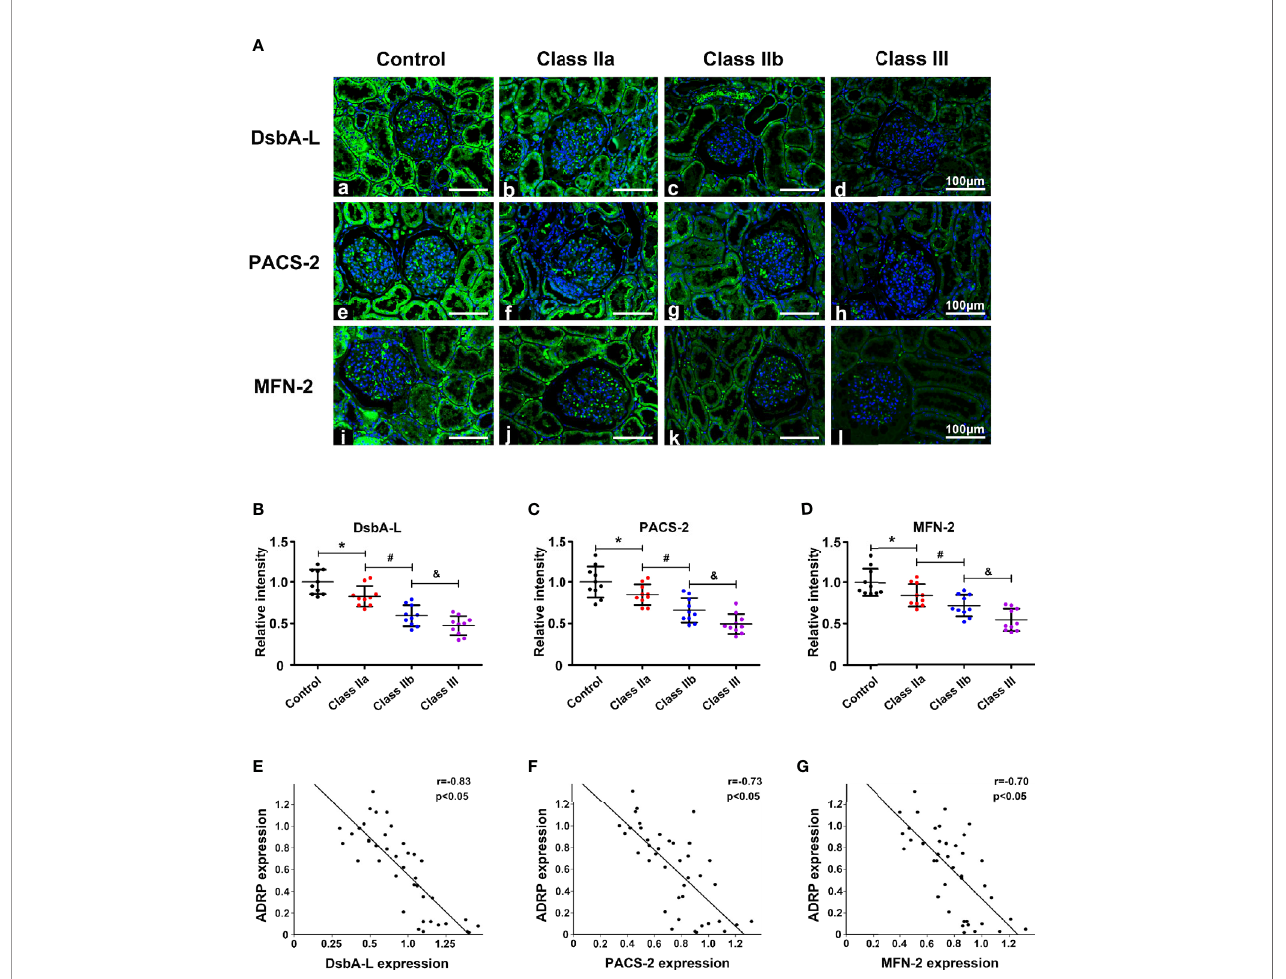
FIGURE 4 | The expression of MAM-control proteins (DsbA-L, PACS-2, and MFN-2) and the correlation between these proteins and ADRP. One-way ANOVA was used to compare the differences among groups, and the correlation of the two numerical variables was tested by Pearson ’ s analysis. (A) IHC staining revealed a notably reduced expression of DsbA-L, PACS-2, and MFN-2 in the kidneys of DN patients. Scatter diagram representing the levels of DsbA-L (B) , PACS-2 (C) , and MFN-2 (D) . (E) Correlation analysis between the expression of DsbA-L and ADRP. (F) Correlation analysis between the expression of PACS-2 and ADRP. (G) Correlation analysis between the expression of MFN-2 and ADRP. Experiments were performed at least three times for each donor, with a minimum of fi ve random fi elds taken per condition. Values are the mean±SD. *p < 0.05 compared with the control group; # p < 0.05 compared with the class IIa group; & p < 0.05 compared with the class IIb